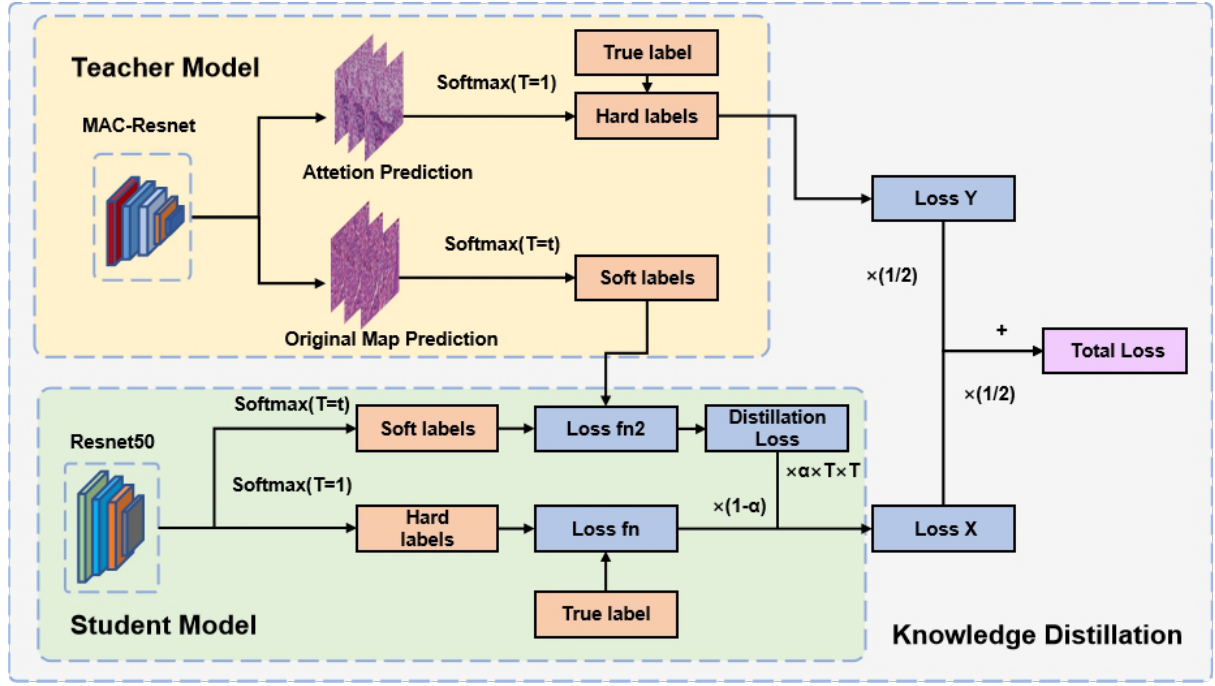
Figure 3. Details of Knowledge Distillation: MAC-ResNet is used as the teacher network to guide the training of student network ResNet, and the simplified network can also achieve better classification effects in the ZLet